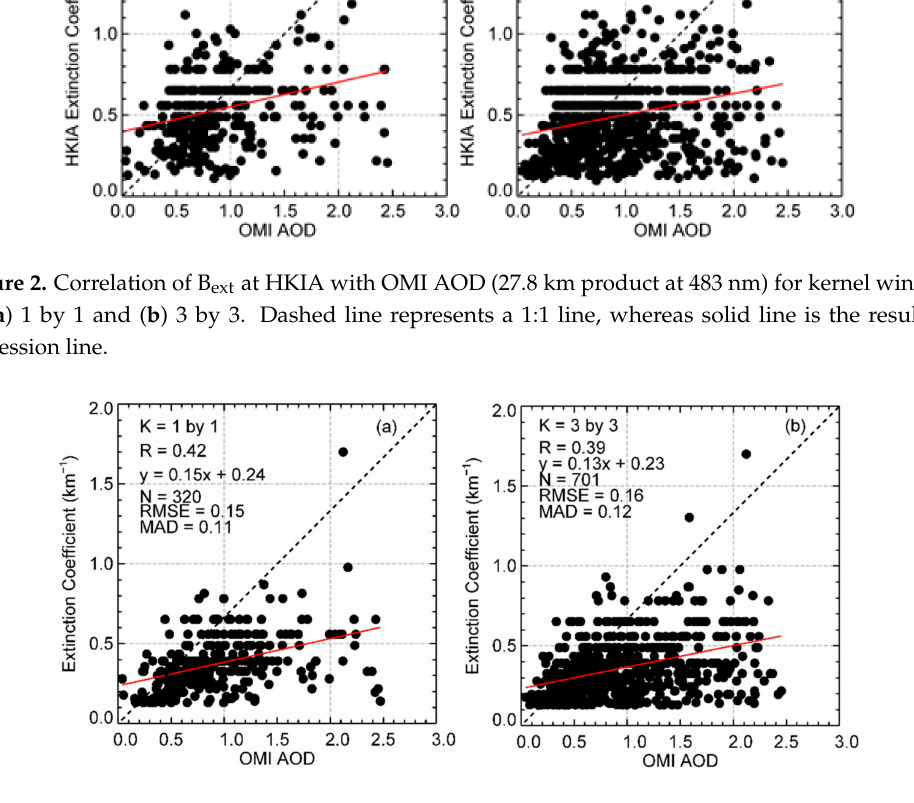
Figure 3. Like Figure 2, but at